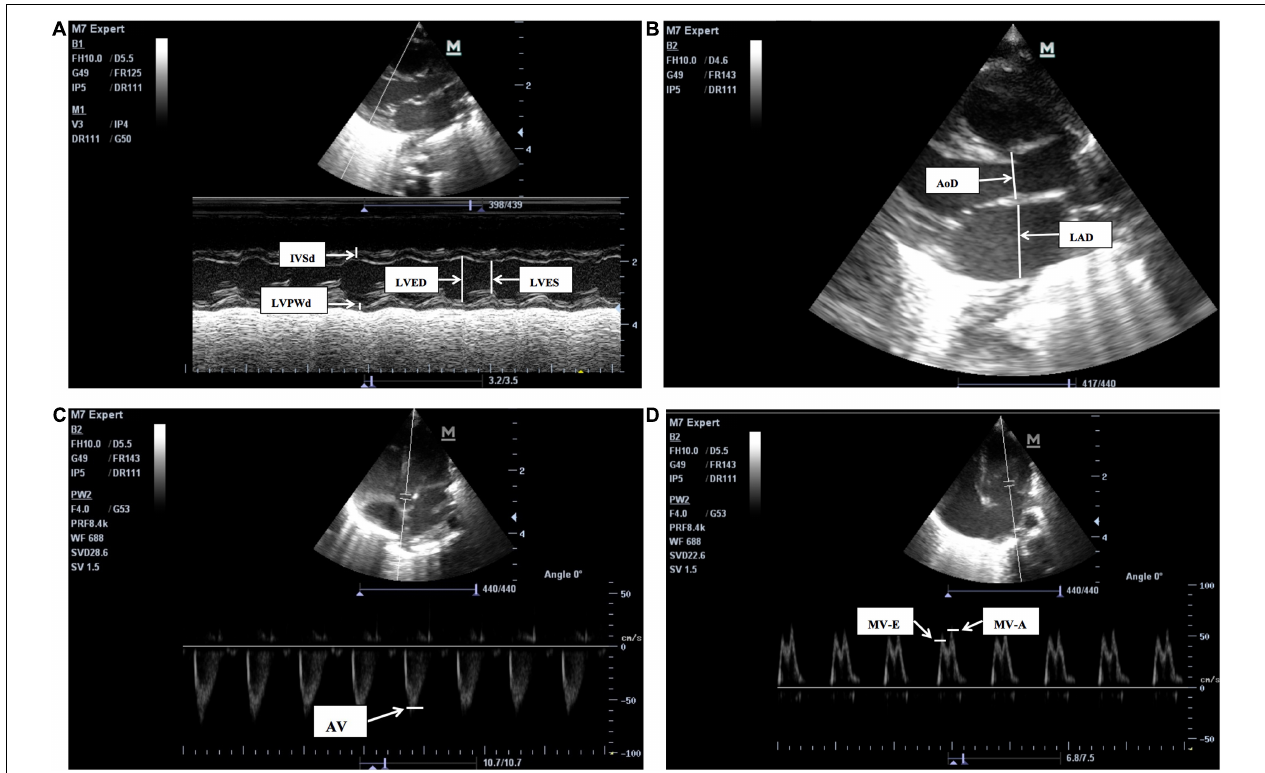
FIGURE 1 | The two-dimensional (2D), M-mode or Doppler echocardiographic measurements pictures for LV structure and function. (A) The M-mode echocardiographic measurements for left ventricle and interventricular septum. IVSd, end-diastolic interventricular septum, LVPWd, left ventricular posterior wall end-diastolic thickness, LVED, Left ventricular end-diastolic, LVES, left ventricular end-systolic, LVFS, left ventricular fractional shortening, LVEF, left ventricular ejection fraction. LVFS (%), (LVED-LVES)/LVED × 100, LVEF is calculated by Teichholtz method. (B) The 2D measurements of left atrium diameters (LAD) and aortic root diameters (AoD), were taken in end-systole at the level of the aortic valves. LA/AO = LAD/AoD. (C) The pulsed wave Doppler measurements for aortic valve flow rate (AV). (D) The pulsed wave Doppler measurements for peak mitral valve flow rate E(MV-E), peak mitral valve flow rate A(MV-A), the peak mitral valve flow rate E to A (MV-E/A),